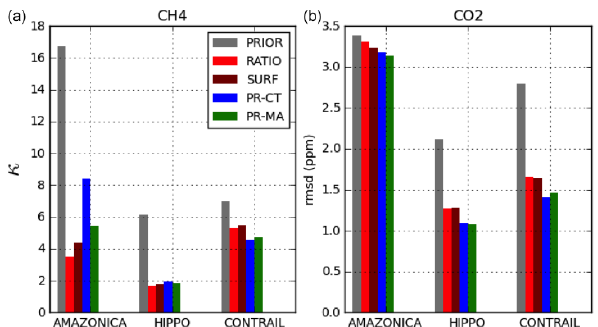
Figure 9. Summary of aircraft validation results per project for CH 4 ( a , expressed as κ ) and CO 2 ( b , expressed as RMSD) for the whole inversion time period i.e., from 1 January 2009 to 31 December